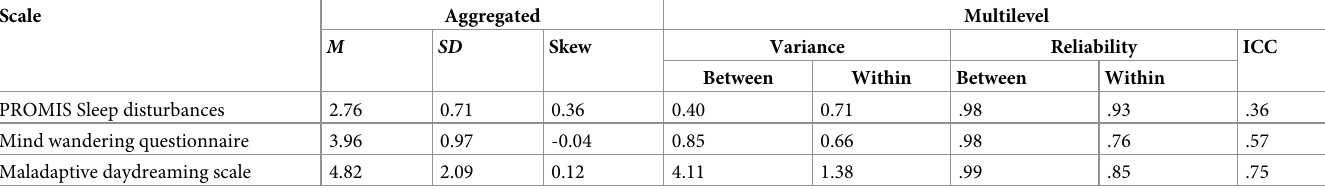
Table 1. Descriptive summary of research instruments measured daily over 8 Days (= 126 Individuals & 869 Observations).